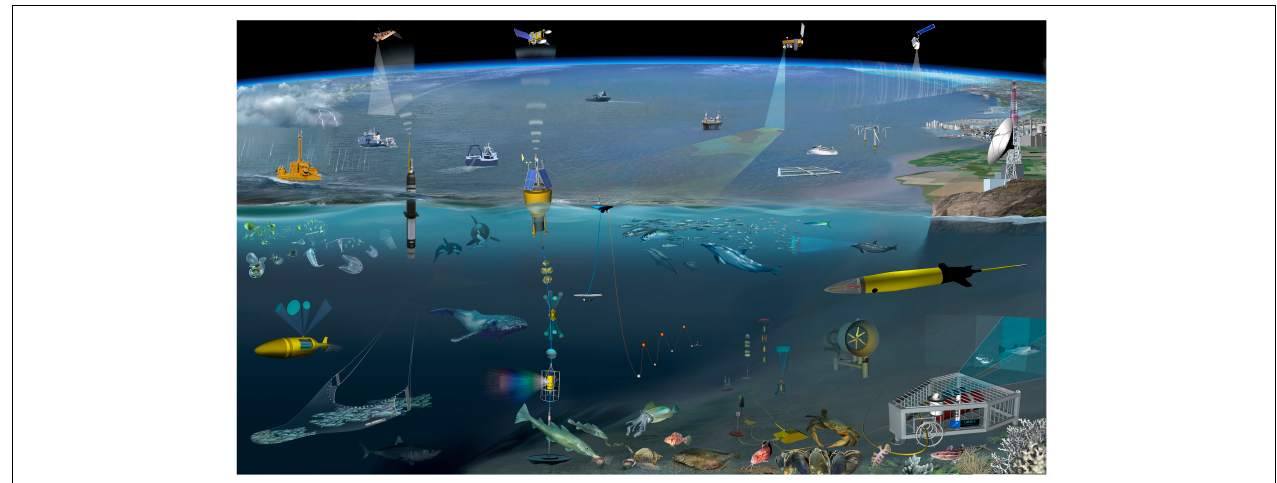
FIGURE 1 | A depiction of the many autonomous and remote sensing platforms that comprise an ocean observation system (source: Glynn Gorick and the NeXOS